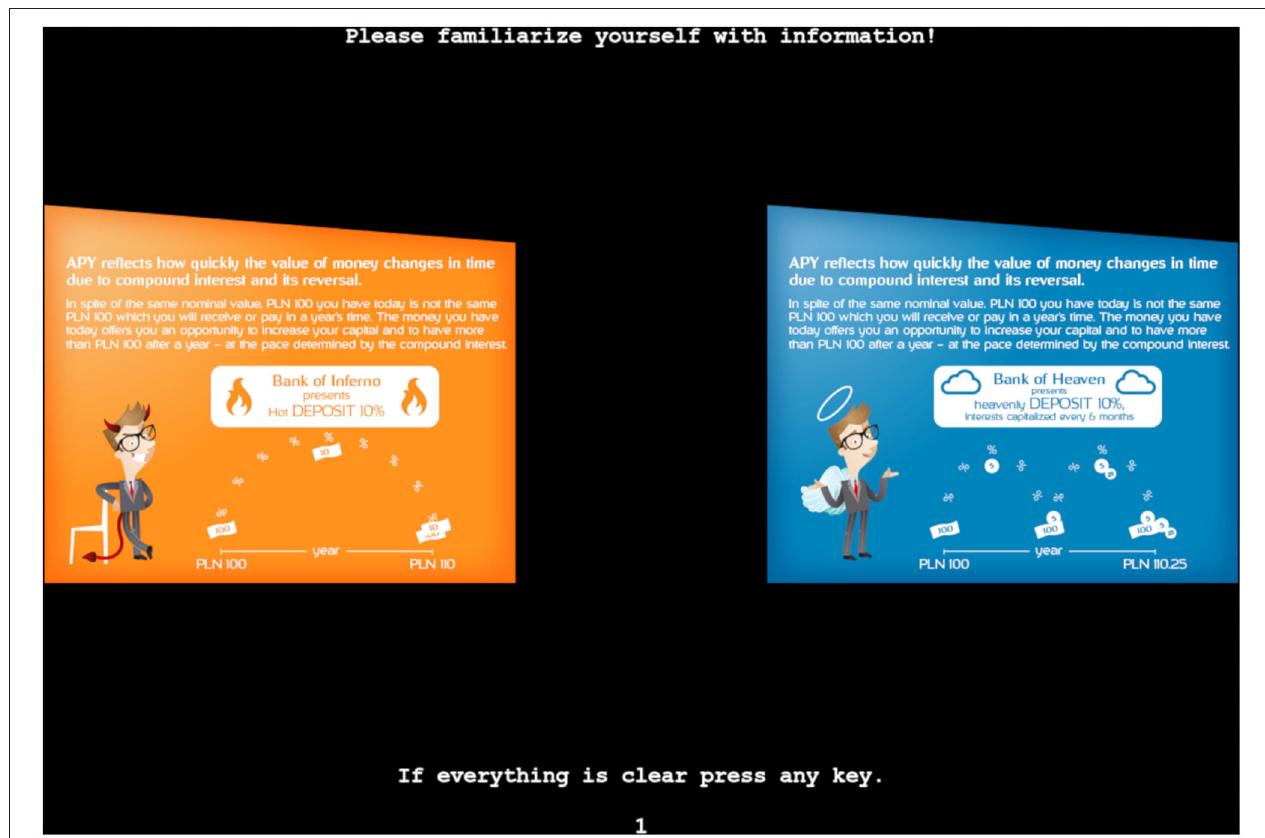
FIGURE 2 | Representative infographic (1)—Negatives vs. positives of calculating and not calculating compound interest.